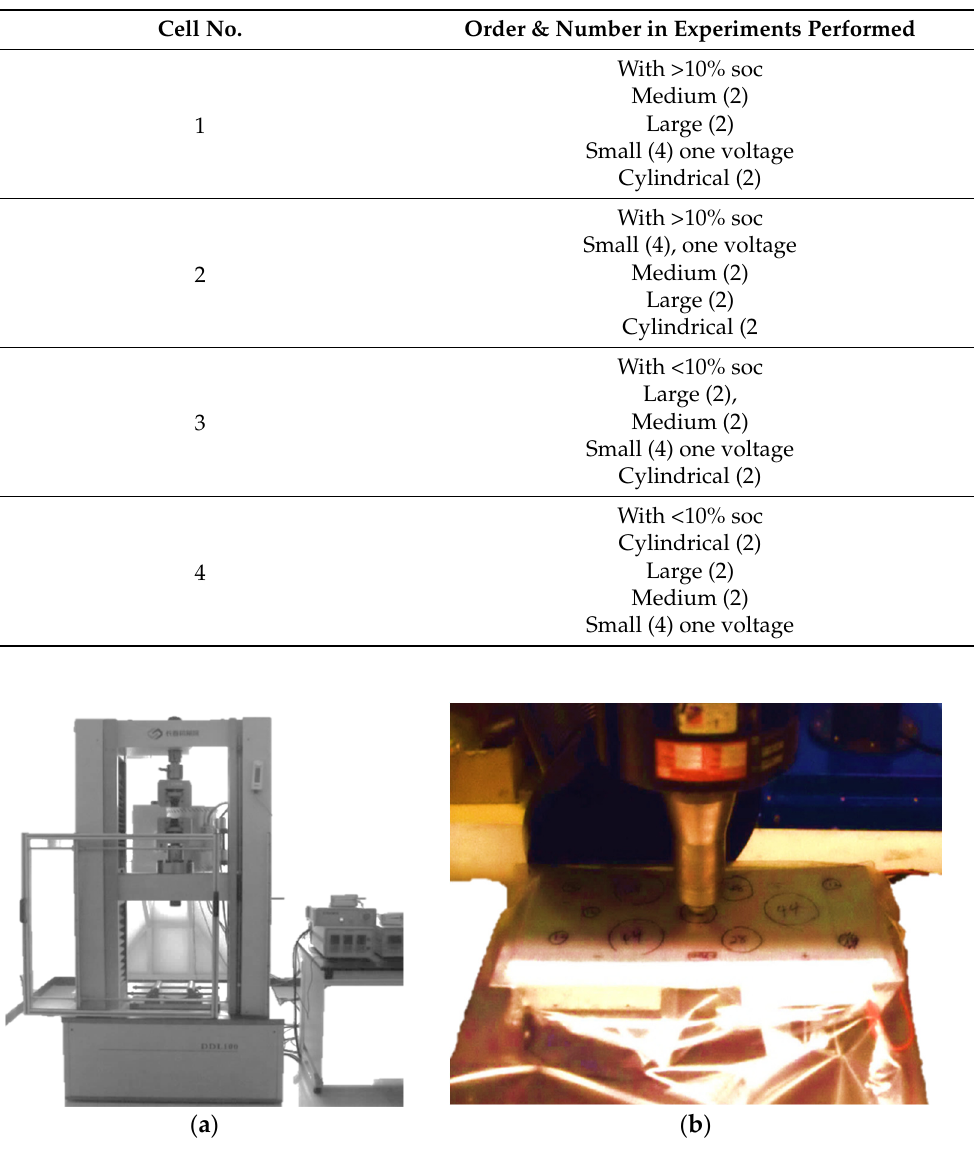
Table 2. Number of tests on each cell.